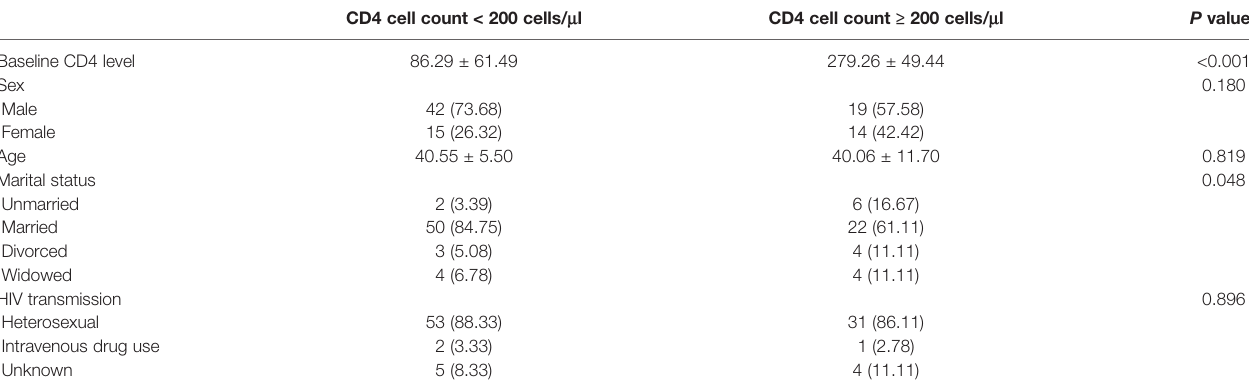
TABLE 1 | Descriptive statistics strati fi ed by baseline CD4